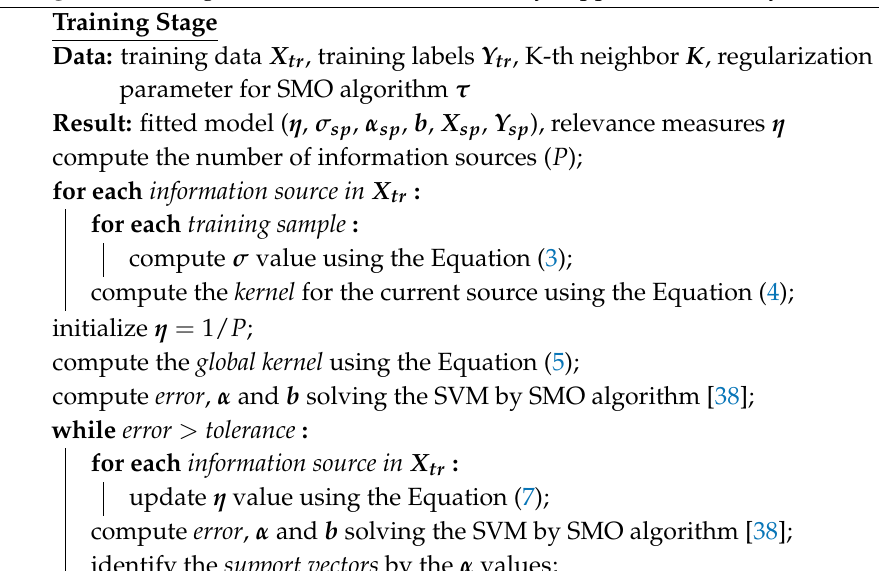
Algorithm 2: Algorithm with data reduction by support vectors only Training